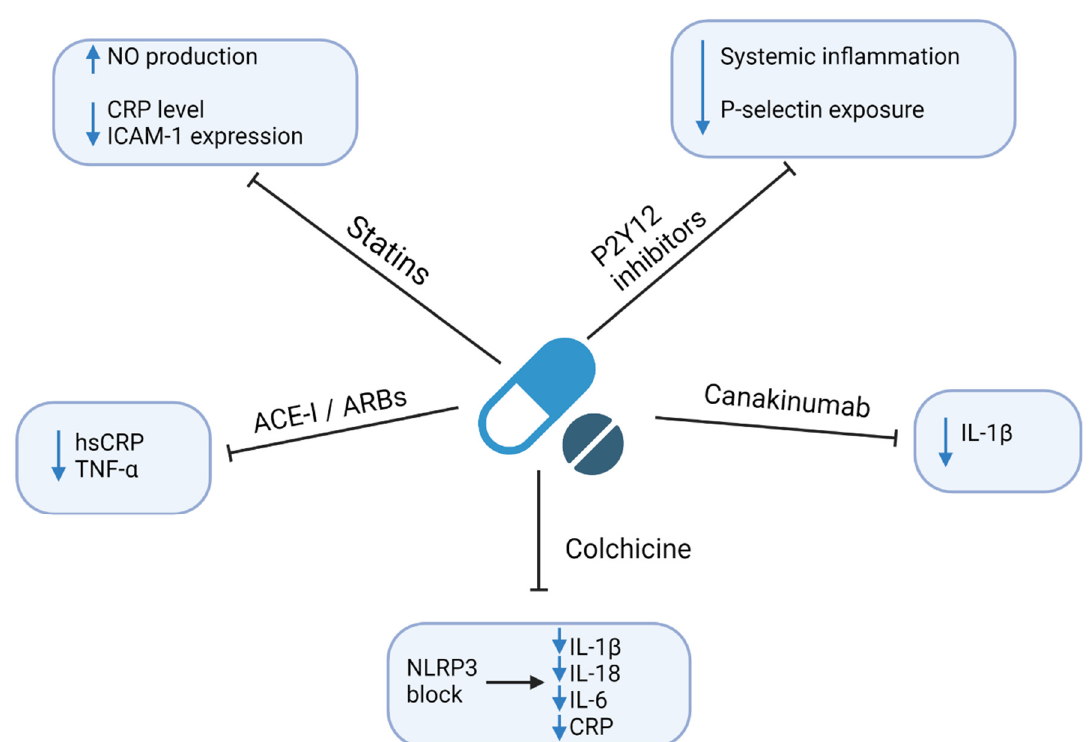
Figure 3. Anti-inflammatory and/or anti-infective mechanisms of currently available drugs. Abbreviations: ACEI— angiotensin-converting enzyme inhibitor; ARBs—angiotensin II receptor blocker; CRP—C-reactive protein; hsCRP—high- sensitivity CRP; ICAM-1—Intercellular Adhesion Molecule 1; IL—interleukin; NLRP3—nucleotide-binding oligomerization domain-like receptors, pyrin domain-containing 3; NO—nitric oxide; TNF- α —tumor necrosis factor-alpha. Created with Biorender.com, licensed version.